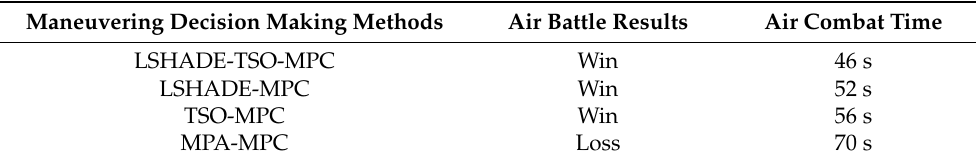
Table 5. Four algorithms combined with the MPC framework against LSHADE-TSO. Maneuvering Decision Making